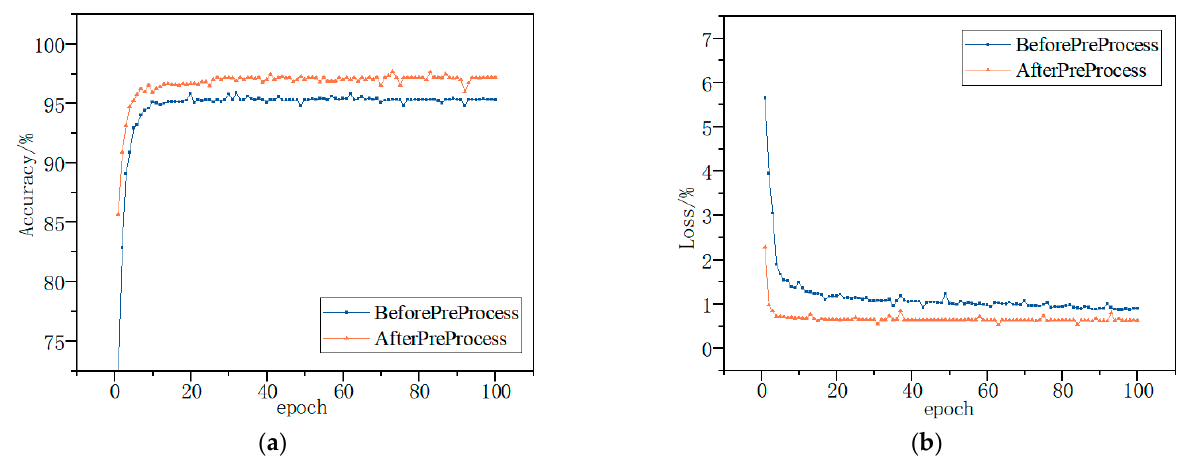
Figure 11. Kaggle dataset accuracy and loss; they should be listed as: ( a ) Description of accuracy; ( b ) Description of loss.